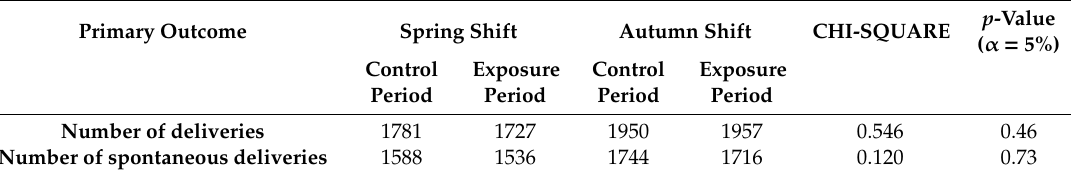
Table 3. Summarized data of results of primary outcome.